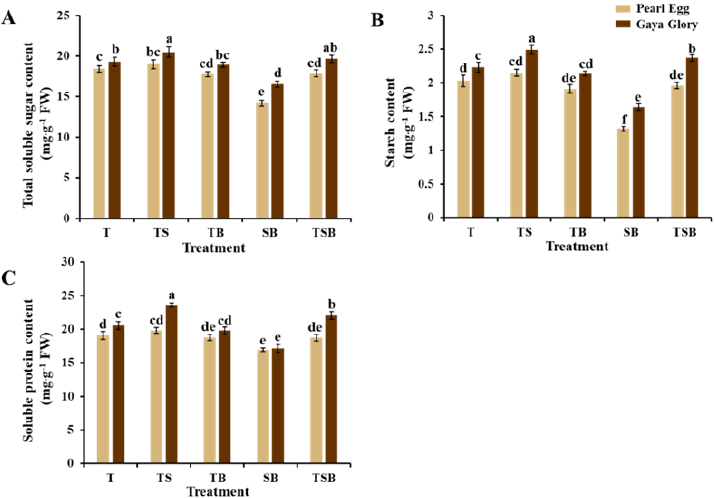
Figure 8. Changes in the content of carbohydrates ( A , B ) and soluble proteins ( C ) of chrysanthemum “Pearl Egg” and “Gaya Glory” plants as affected by the different lighting direction combinations after 45 days of cultivation. T, TS, TB, SB, and TSB, refer to top (1/1), top (1/2) + side (1/2), top (1/2) + bottom (1/2), side (1/2) + bottom (1/2), and top (1/3) + side (1/3) + bottom (1/3) lighting, respectively. Vertical bars indicate the means ± standard error ( n = 6). Different lowercase letters indicate significant separations within treatments by Duncan’s multiple range test at p ≤